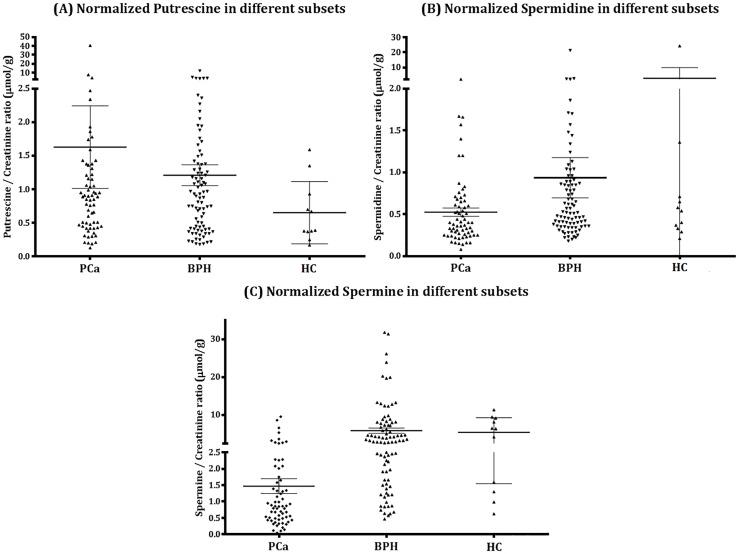
Distribution of (A) normalized Put, (B) normalized Spd, (C) normalized Spm values in PCa, BPH and HC.The black bar in the figures indicates the mean value of each subset while the error bar indicates the corresponding SEM.